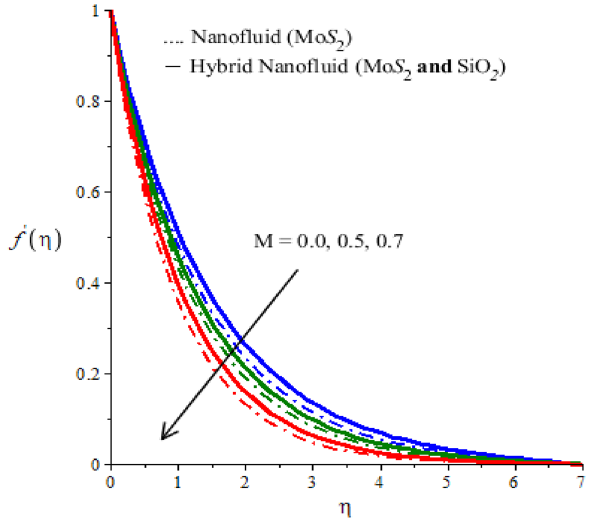
Figure 4. Horizontal velocity profiles of mono nanofluid (dotted curves) and hybrid nanofluid (solid curves) for M when Pr = 204, (cid:31) E = 0.01, h s = 1.3, n = 2, φ 1 = 0.004, φ 2 = 0.0075.